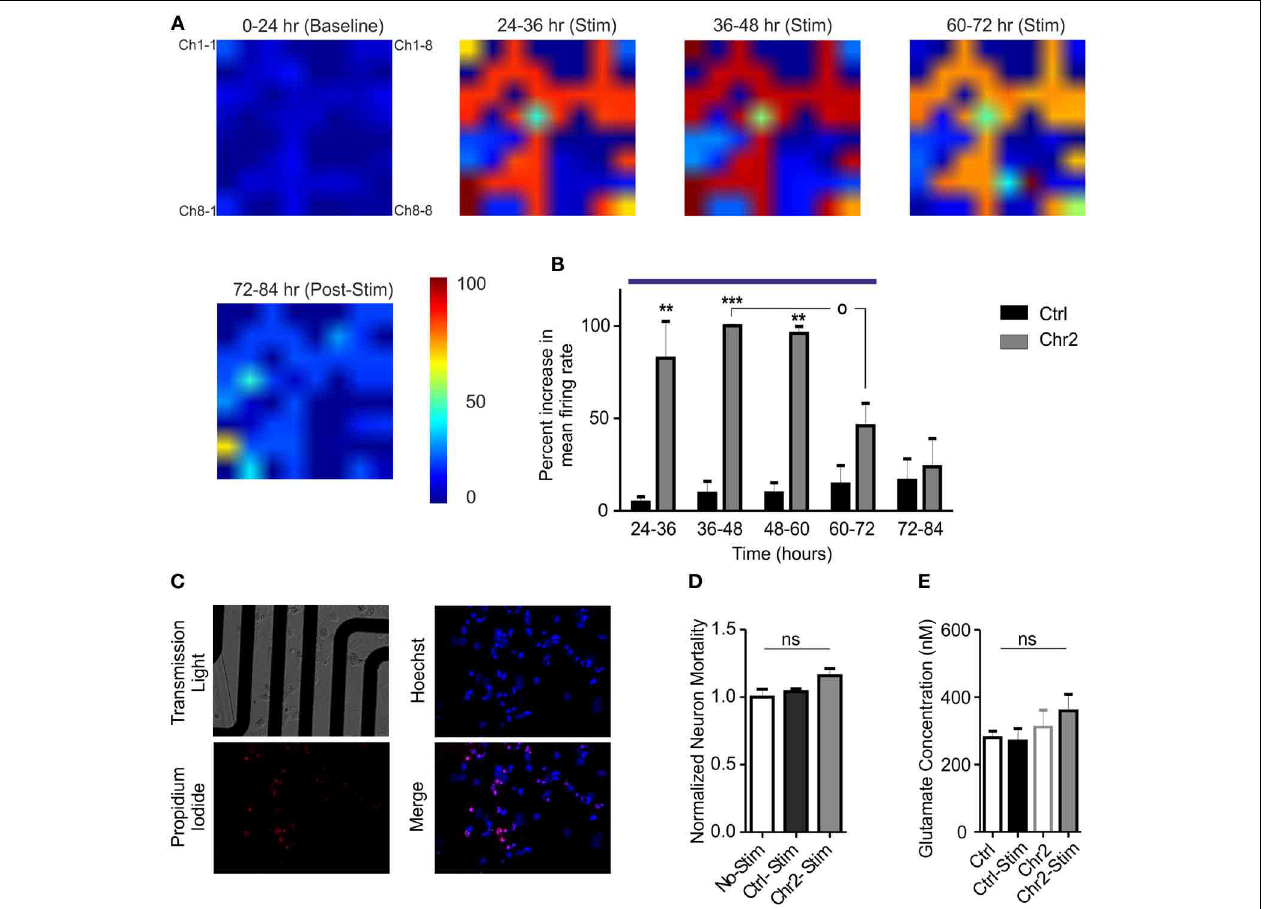
FIGURE 5 | Chronic stimulation with light pulse trains induces an adaptive response in hippocampal networks. (A) Color map of the mean firing rate recorded on MEAs before (0–24h epoch), during the administration of the photostimulation protocol (5 light pulses of 10ms at 40Hz every min for 48h; 24–72h epochs) and after stimulation (72–84 epoch). Color areas represent the normalized increases in the mean firing rate in the various epochs (see Materials and Methods and the look-up table reported on the right for pseudocolor coding). (B) The increase in the firing rate of ChR2/H134R-infected networks (gray bars; n = 5), measured in 12h epochs, was normalized to the peak firing rate of ChR2/H134R-infected neurons over time. The normalized mean firing rate of stimulated control YFP-infected networks (black bars; n = 5) is shown for comparison. Networks expressing ChR2/H134R show neuronal adaptation to the chronic light stimulation (blue horizontal bar).